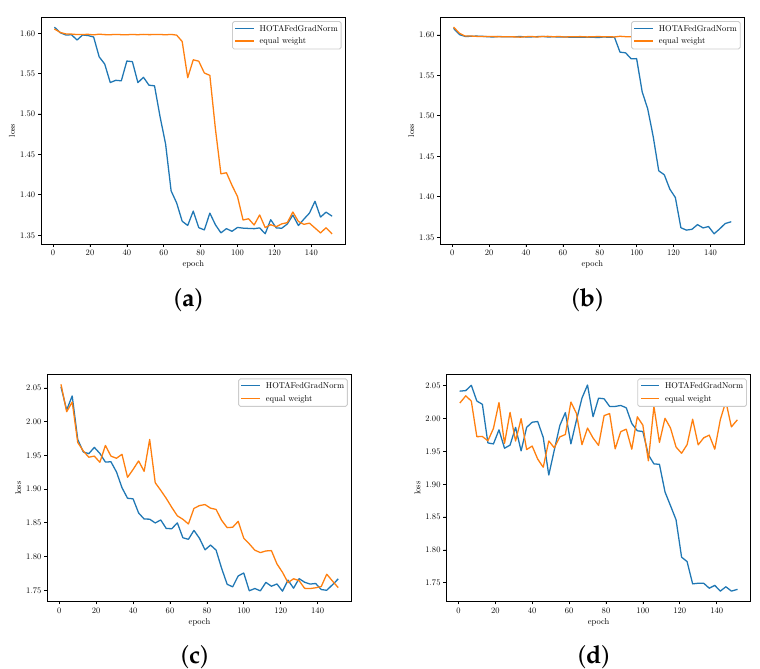
Figure 7. Comparison between task loss achieved via HOTA-FedGradNorm and naive equal weighting = 0.75 and σ 2 = 1 for ∀ l ≥ 3 ( a ) task 1 (modulation case in RadComDynamic dataset where σ 2 2 l = 2, ( b ) task 1 (modulation classification) when σ 2 = 0.25, ( c ) task 2 (signal classification) when σ 2 1 1 = 2, ( d ) task 2 (signal classification) when σ 2 = classification) when σ 2 1 1